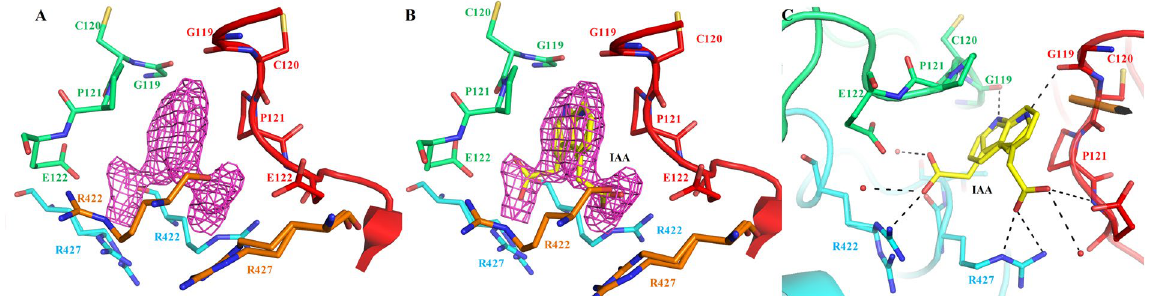
Figure 4. The structural insights of putative auxin binding site. ( A ) Close-up view of ligand binding pocket showing Fobs-Fcalc electron density map contoured at 2.5 σ . ( B ) Auxin molecule show in two different orientation (shown as sticks) fitted in the F obs - F calc electron density map. ( C ) Intermolecular hydrogen bonds between the auxin molecule and binding site residues formed by chains B, C, E and F. WTG hexamer is shown in cartoon representation with chain B (green), chain C (cyan), chain E (red), and chain F (orange). Auxin molecule and side chains of residues are shown as sticks. The water molecules are represented as spheres. The hydrogen bonds are shown as dashed black